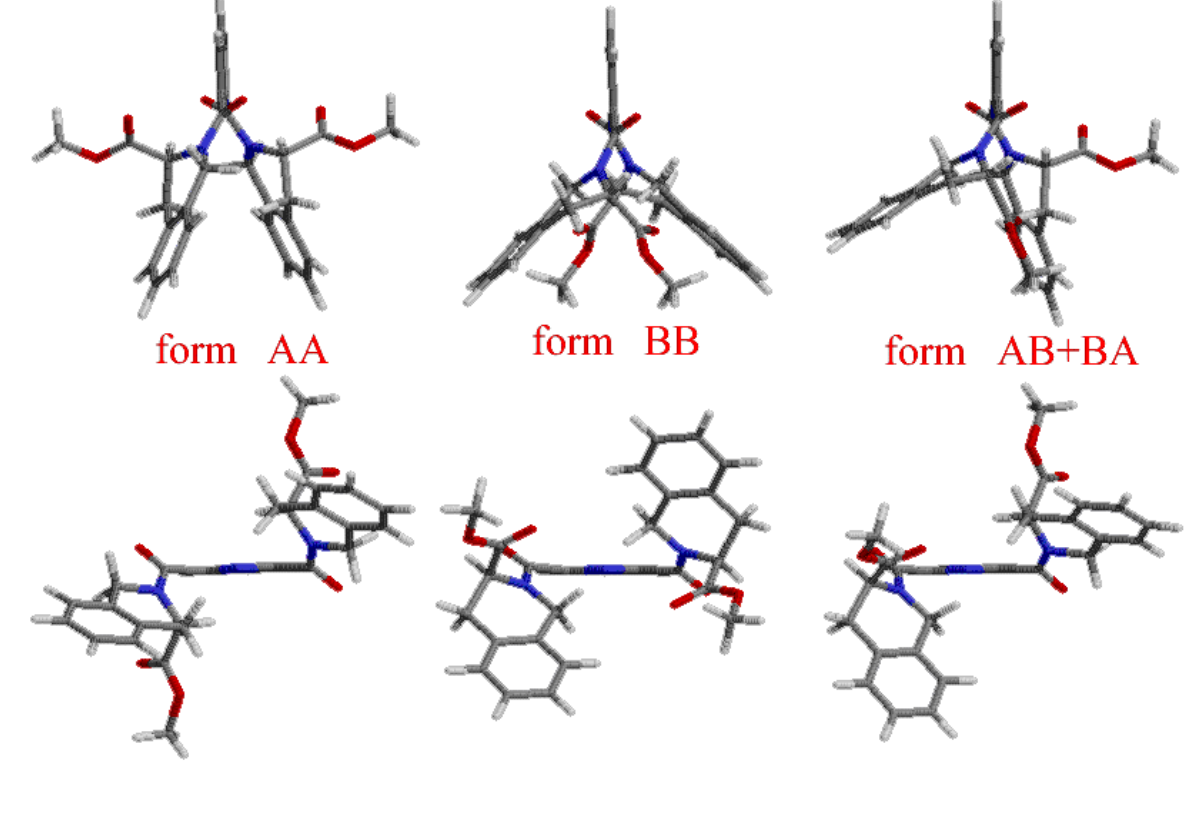
Figure 2. 1 H-NMR spectrum of compound 2 in CDCl